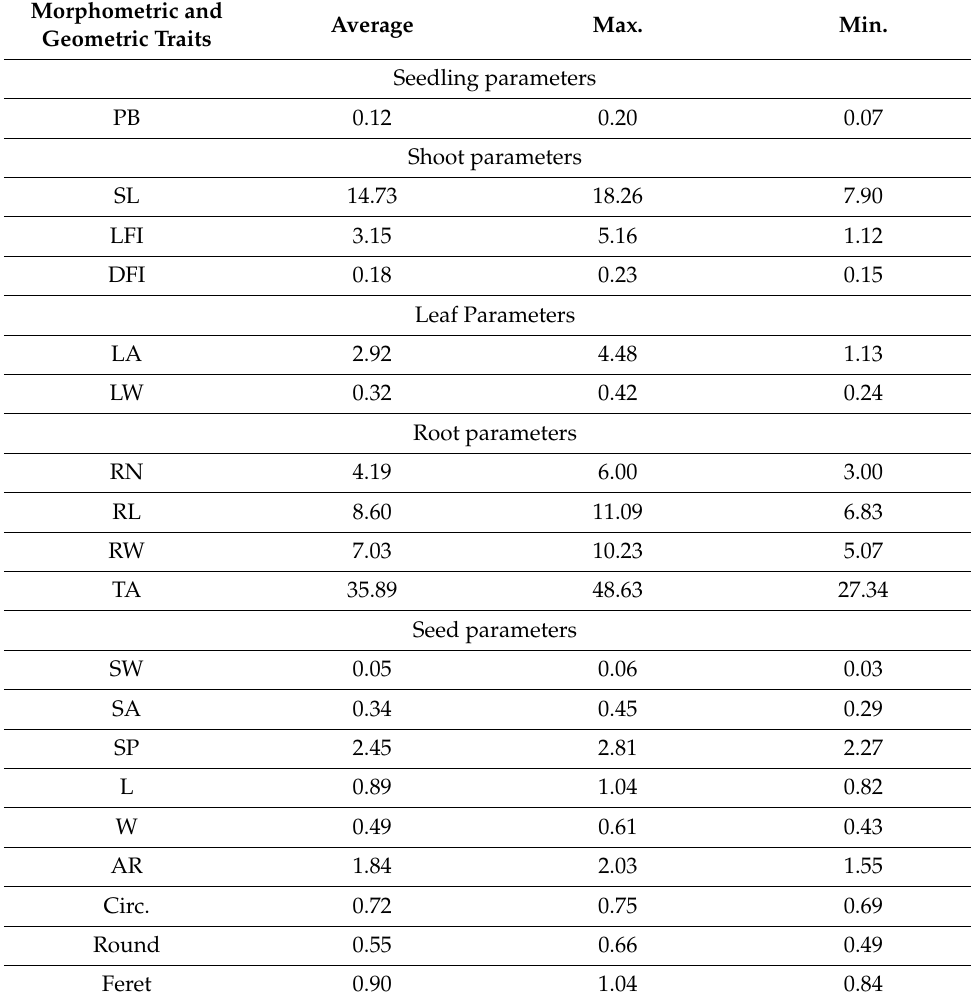
Table 3. Descriptive statistics of 16 days seedling, shoot leaf and root morphometric traits and seed geometric traits of the 16 T. aestivum genotypes studied. Morphometric and Average Max. Min. Geometric Traits Seedling parameters